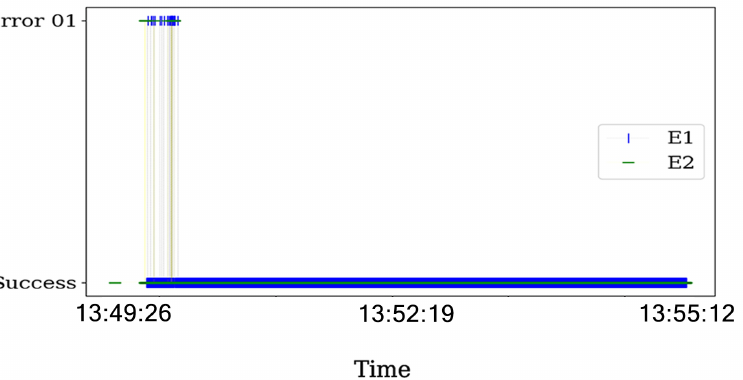
Figure 15. RSS values across the experiments, and the presence of impulsive noise in the time range of 13:48:57 to 13:49:17 for both transmitters.